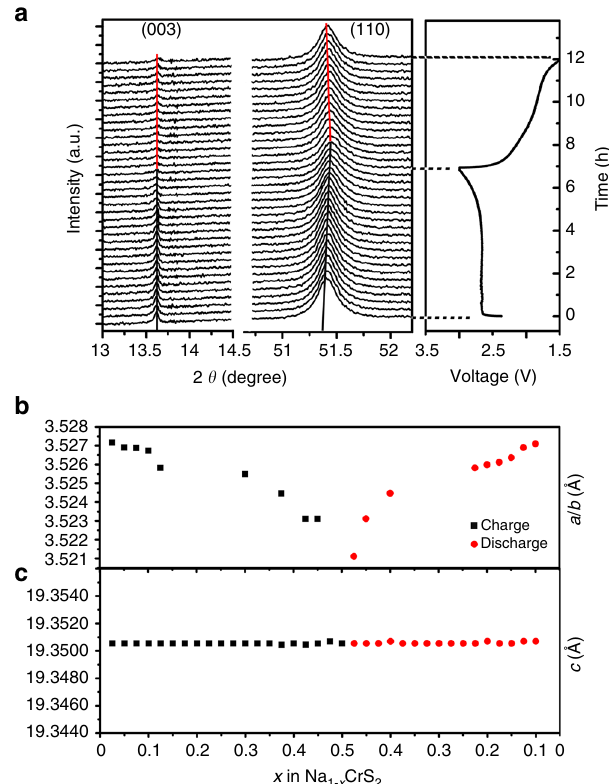
Fig. 2 Structural evolution of NaCrS 2 during sodium deintercalation and intercalation. a In situ XRD during the initial cycle for NaCrS 2 , corresponding voltage curve is shown on the right . The 2 θ is converted to the corresponding angle for λ = 1.54 Å (Cu-K α ) from the real wavelength λ = 0.7747Å used for synchrotron XRD experiments. Evolution of lattice parameters b a/b and c c calculated from the in situ XRD during the fi